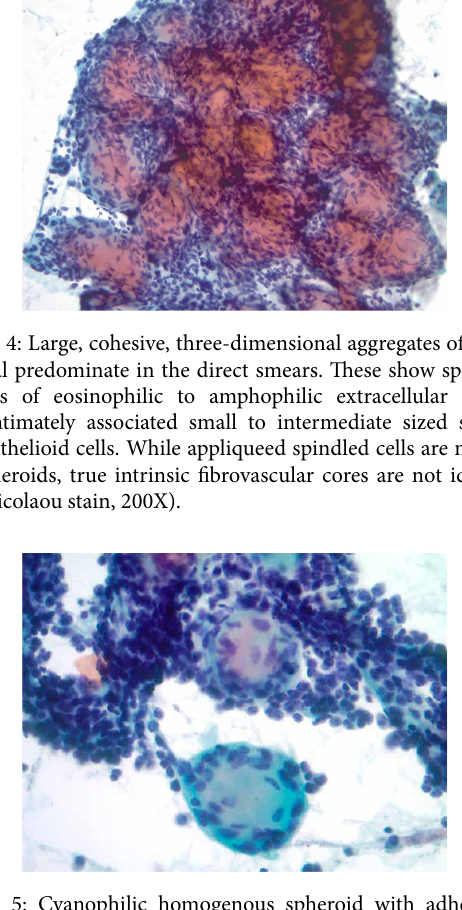
Figure 5: Cyanophilic homogenous spheroid with adherent or intrinsic bland spindled cells (fibroblasts) and collections of small, high nuclear/cytoplasmic ratio round to oval smears intervening between (Papanicolaou stain,